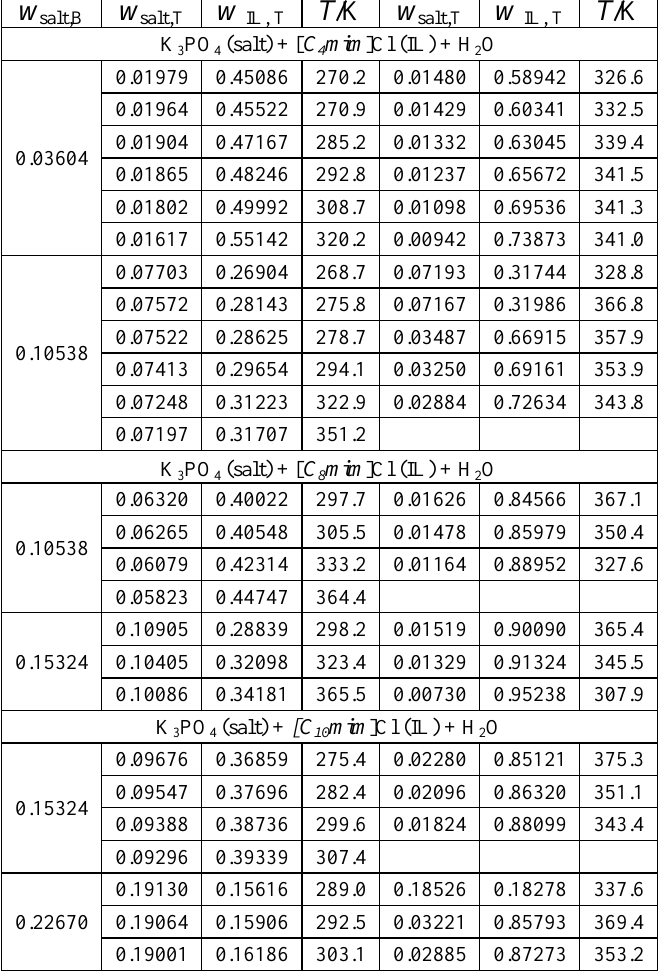
Table 2. Cloud-point temperature, T , as a function of composition (mass fraction, w ) of chloride-based ionic-liquid solutions. The B and T subscripts denote the compositions of the initial K solution and of the ternary solutions,